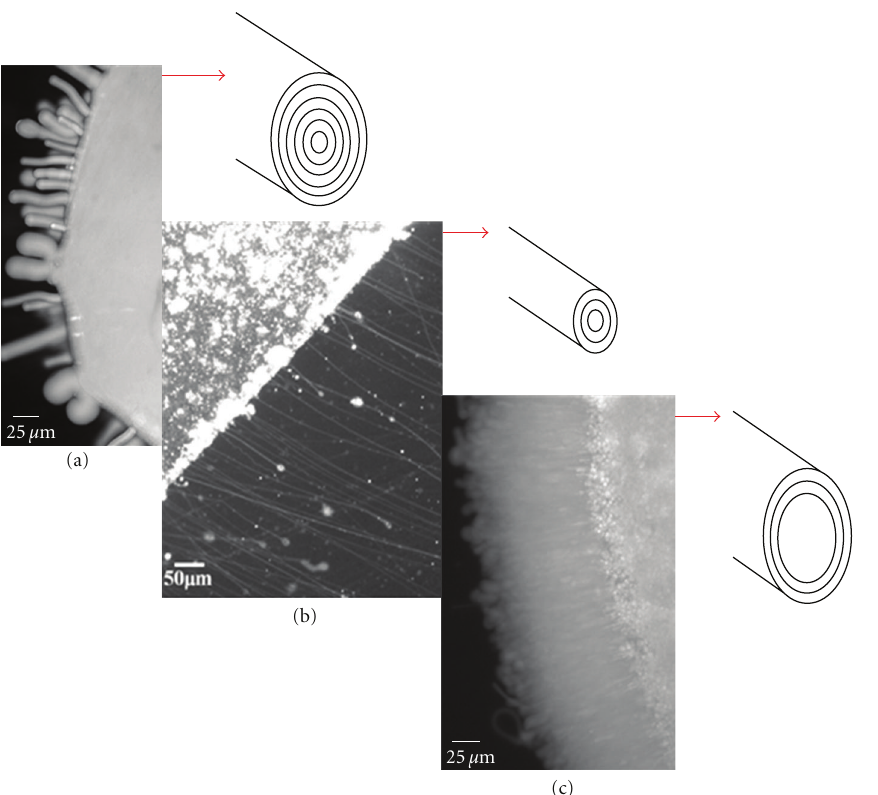
Figure 3: Wide-area fluorescent micrographs illustrating three major types of tubule morphologies observed upon the hydration of dry stack lipid doped with 1mol% Texas Red by water above their phase transition temperature. (a) Solid tubes: large number of lamellar. (b) Thin tethers: low number of lamellae with small core radius. (c) Hollow tubes: low number of lamellae with large core